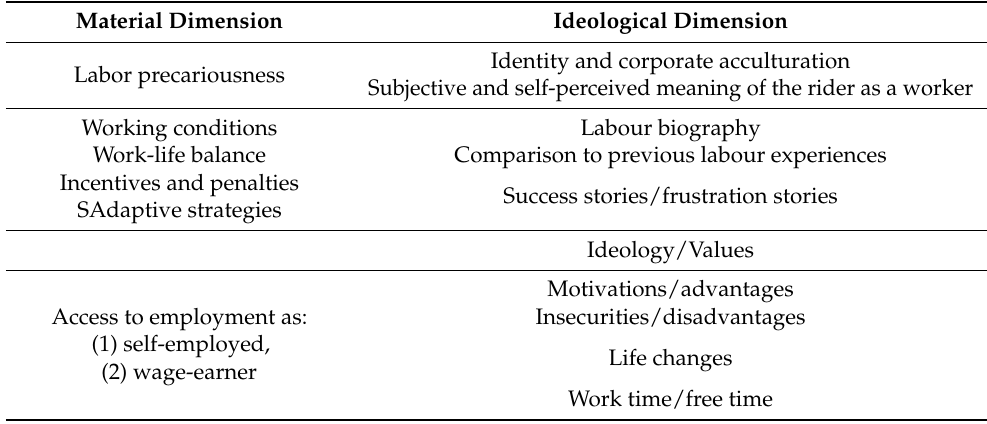
Table 2. Dimensions for the analysis of fieldwork